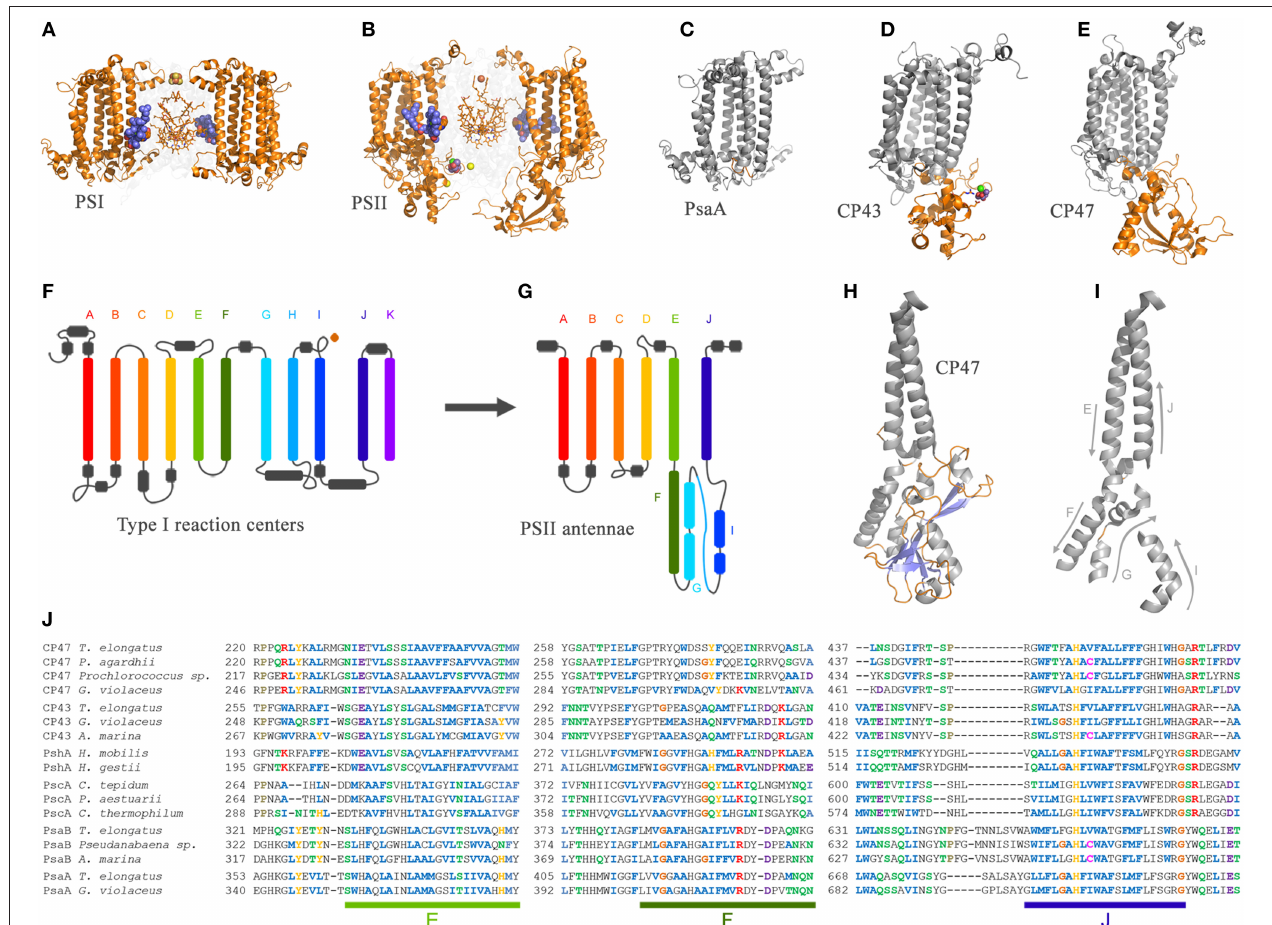
FIGURE 3 | Comparison of the antenna domain of Photosystem I reaction center proteins and the antenna proteins of Photosystem II from the crystal structures PDB ID: 1JB0 and 3WU2 from Thermosynechococcus spp., respectively. (A,B) highlight the core antenna of Photosystem I and II respectively (orange). Blue spheres highlight the conserved peripheral chlorophylls that allow excitation energy transfer from the core antenna to the reaction center, named Chl Z and Chl D in Photosystem II. (C–E) highlight the differences between the antenna domain of the PsaA subunit of Photosystem I with that of the CP43 and CP47, respectively. Note that the extrinsic domain is absent in PsaA. Panels (F,G) show and schematic representation of a Type I reaction center and a Photosystem II antenna protein. The alpha-helices have been color coded to show the homologous positions. Panels (H,I) show detail of the folding pattern of the extrinsic domain from the CP47 subunit. Panel (J) shows a sequence alignment of all Type I reaction center proteins including the CP47 and CP43 subunits. Only three fragments are shown for clarity, those corresponding to transmembrane helices E, F, and J in Type I reaction centers and their respective matching sequences in the antenna proteins of Photosystem II. The sequence alignment was performed using Clustal Omega that applies a Hidden Markov Model-based algorithm ( Sievers et al., 2011). The full alignment is available on